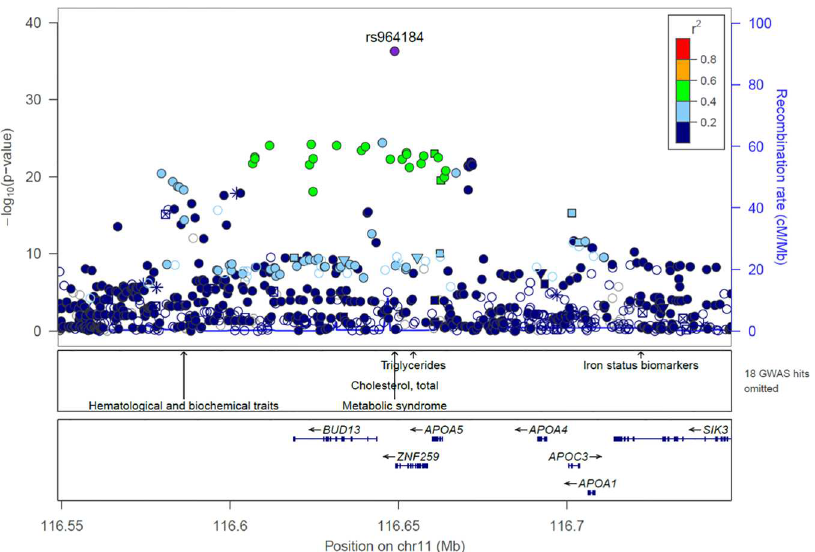
Fig 2. Regional plot showing the results of a meta-analysis of GWA studies in three Hispanic samples (Mexico City 1, Mexico City 2 and Starr County) for TG cholesterol. The regioncovers approximately 200 kb on chromosome11, and includesthe genes BUD13/ZNF259/APOA5